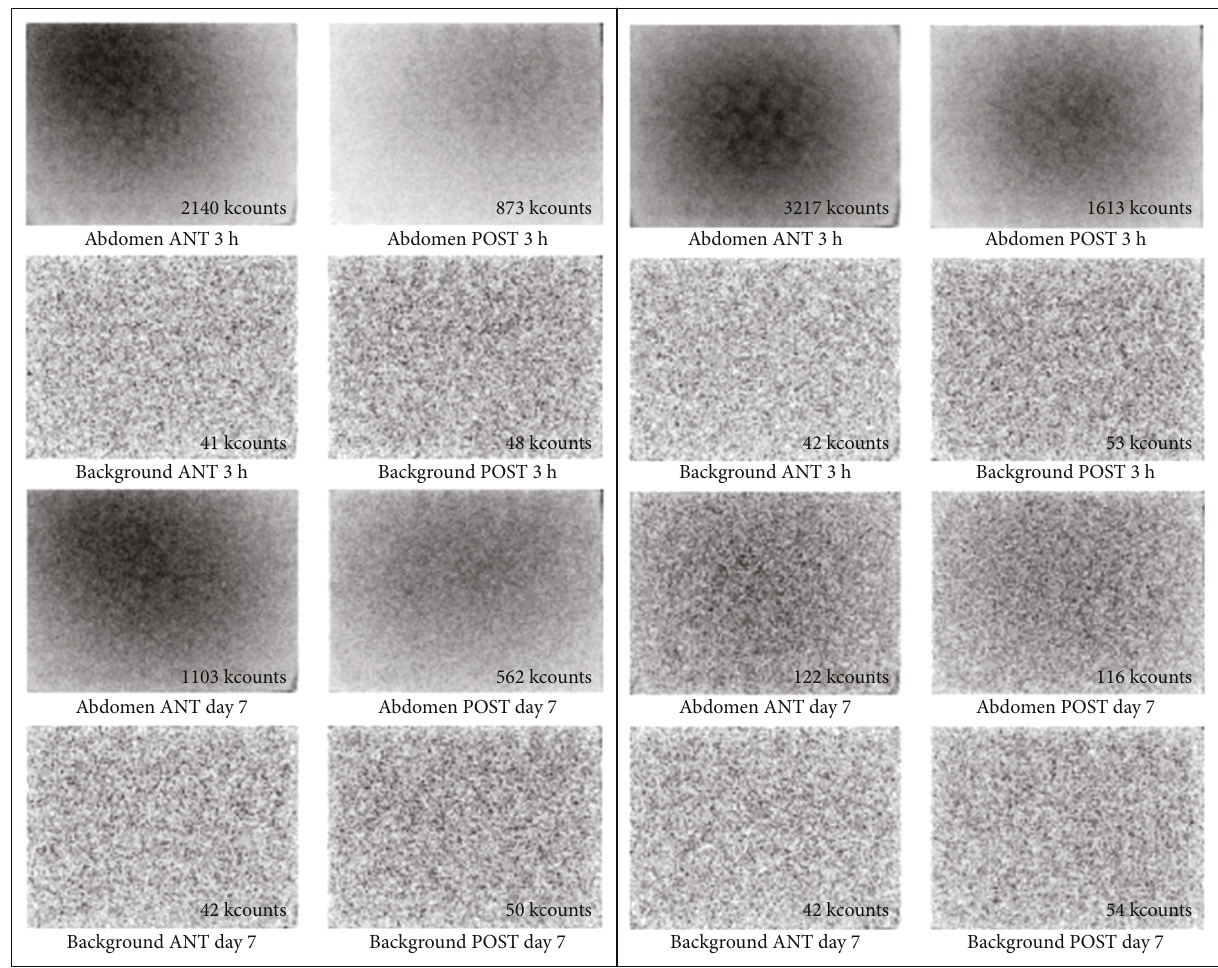
Figure 3: Examples of noncollimated abdomen images and related backgrounds at days 0 and 7 of a pathologic (a) and normal (b) SeHCAT